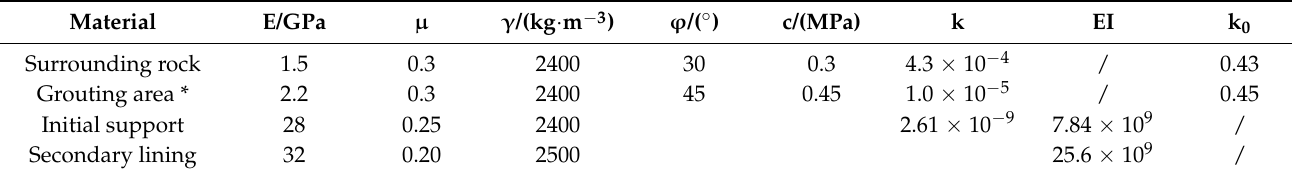
Table 1. Values of relevant parameters.